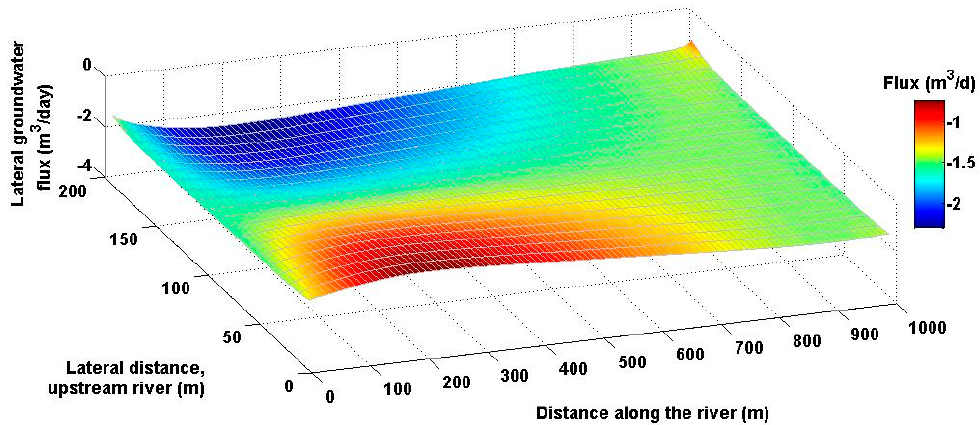
Figure 10. Lateral groundwater flux obtained from STRIVE implementation for the Aa River based on interpolated river boundary with a steady-state simulation.